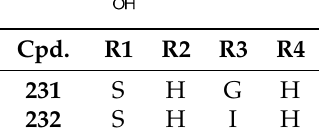
Figure 44. Structures of compounds 231 – 232 .